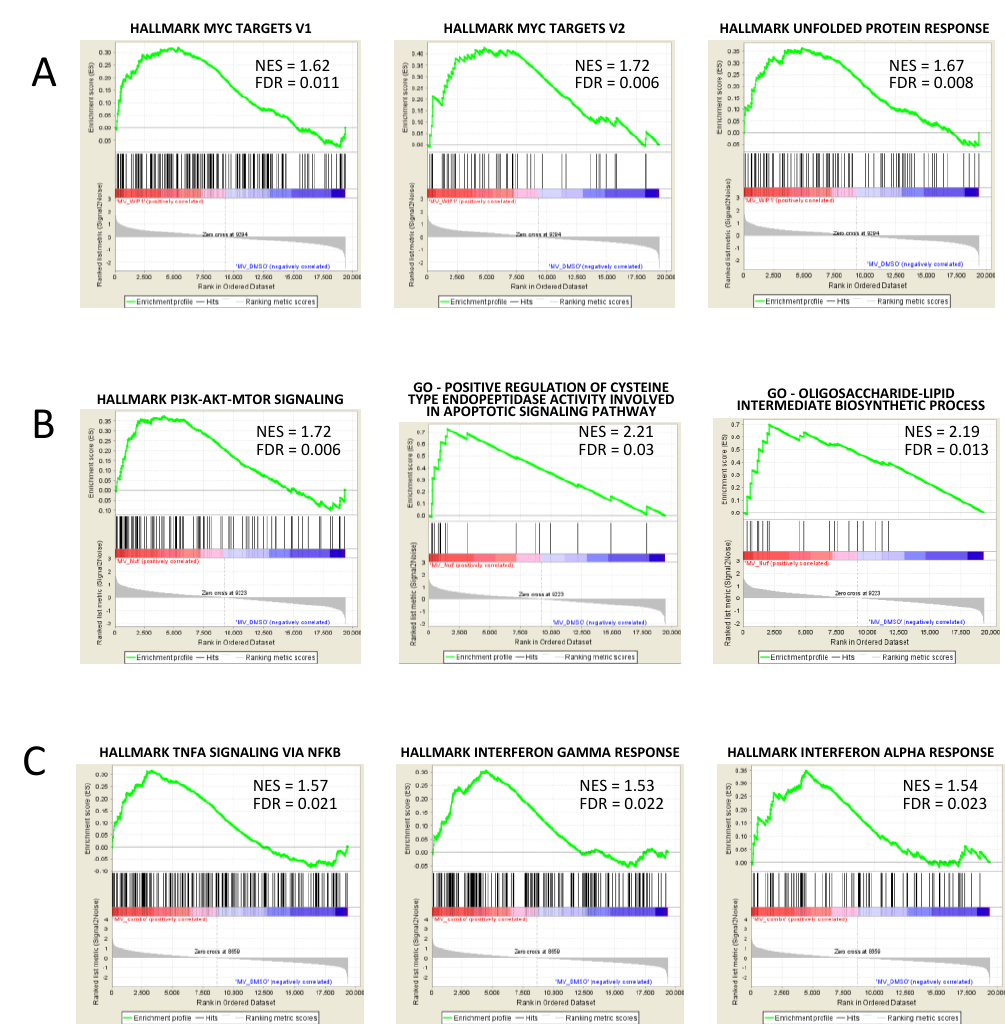
Figure 5. Treatment-specific transcriptional signatures enriched in MV-4-11 and NOMO-1 cells. GSEA plots of significantly enriched signatures in MV-4-11 cells treated with ( A ) WIP1i, ( B ) Nut-3a, or ( C ) their combination vs. control cells (NES: normalized enrichment score, FDR: false discovery rate). Table 3. Most significant enriched pathways in NOMO-1 cells upon drug